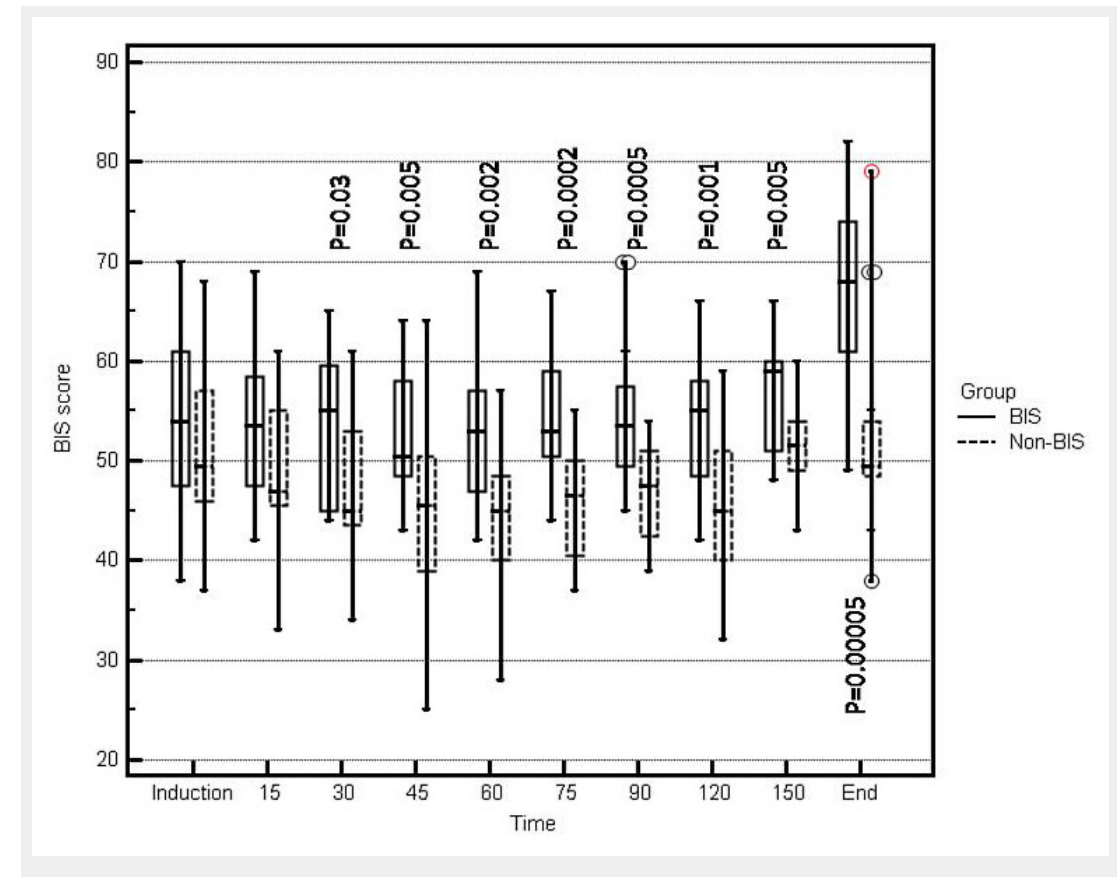
Figure 2 Comparison of BIS score at different time points during surgery between groups of patients with BIS-guided and non BIS-guided anaesthesia. Significant differences are marked and p values are